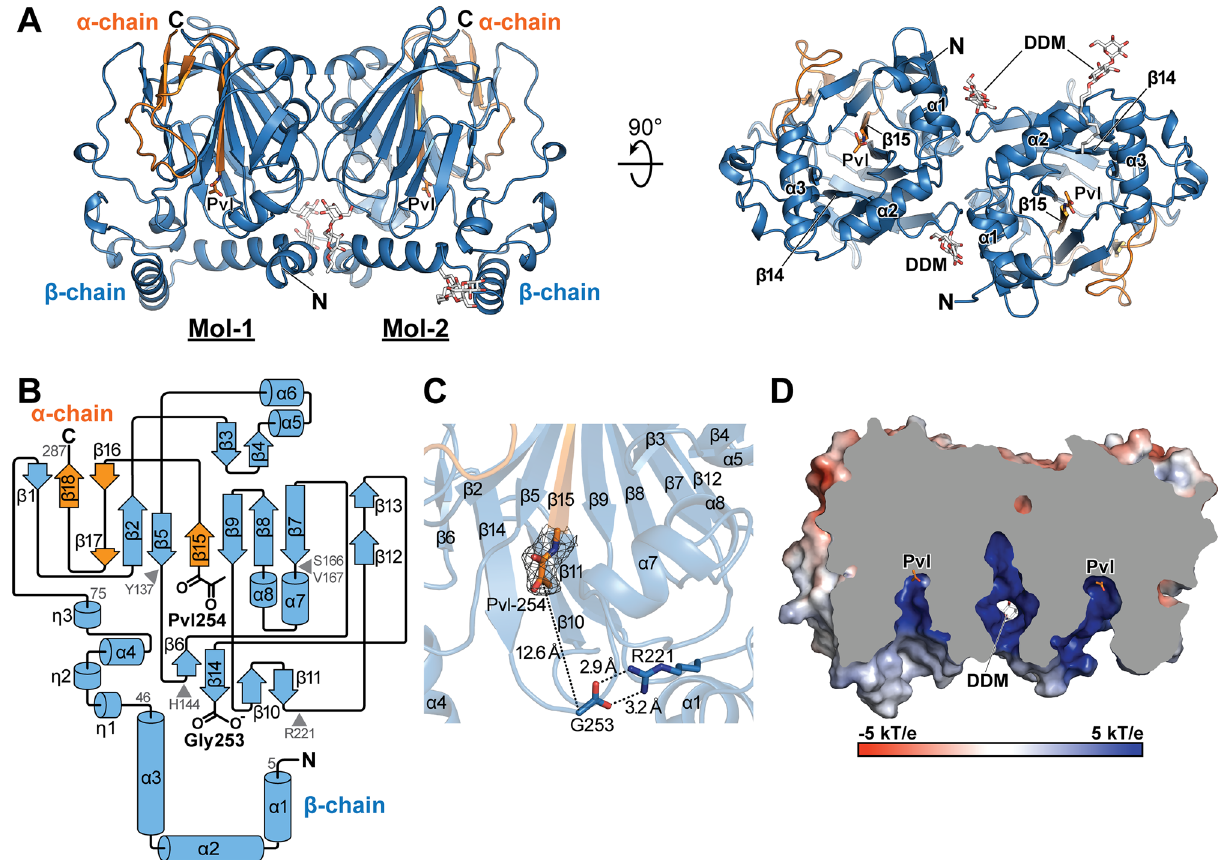
Figure 2. Overall crystal structure of apo E. coli PSD. ( A ) A structure of apo α 2 β 2 heterotetramer. Left and right, two views are related to 90° rotations. The beta chain is illustrated in sky blue, alpha chain in orange, and DDM as stick in white. Pvl, pyruvoyl residue; DDM, dodecyl-beta-d-maltoside. ( B ) Topology of the αβ-heterodimer. An identical color scheme is used as in ( A ). ( C ) A close-up view of the auto-cleaved site. A Fo-Fc omit map for pyruvoyl residue contoured at 3 σ is displayed in mesh. Other residues and DDM were omitted for clarity. Distances between C α of Pvl-254 and Gly-253 and two interactions in salt bridge designated as dashed lines, which were calculated by averaging values from 6 Apo-PSD protomers. ( D ). Sliced view of Apo-PSD1 is shown to highlight the funnel-shaped active site. Electrostatic potential is mapped on the surface of the enzyme. Two pyruvoyl residues on the active sites and DDM molecules are shown in